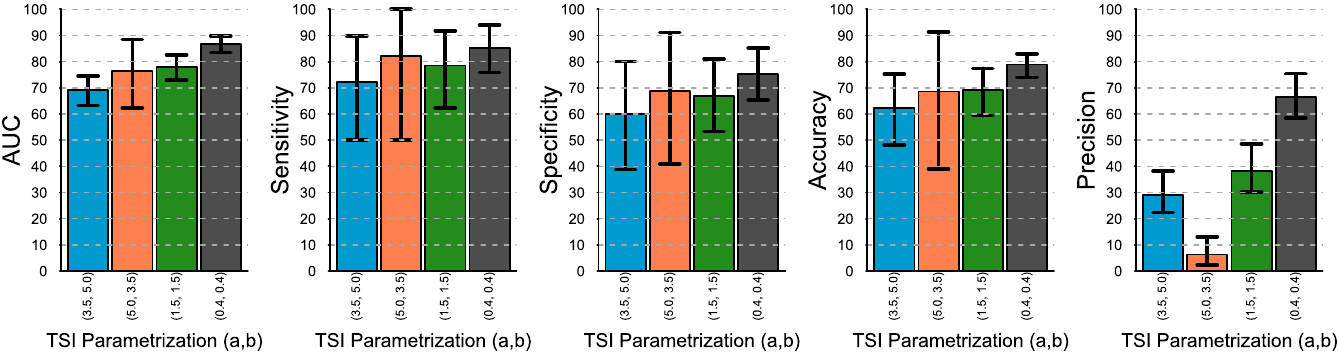
Fig 4. Comparing classification performance of the same assay with different TSI distributions. With u = 0.2, sample size = 500, h = 500, recency at 6 months. The 95% prediction bounds are obtained from 1000 simulations.